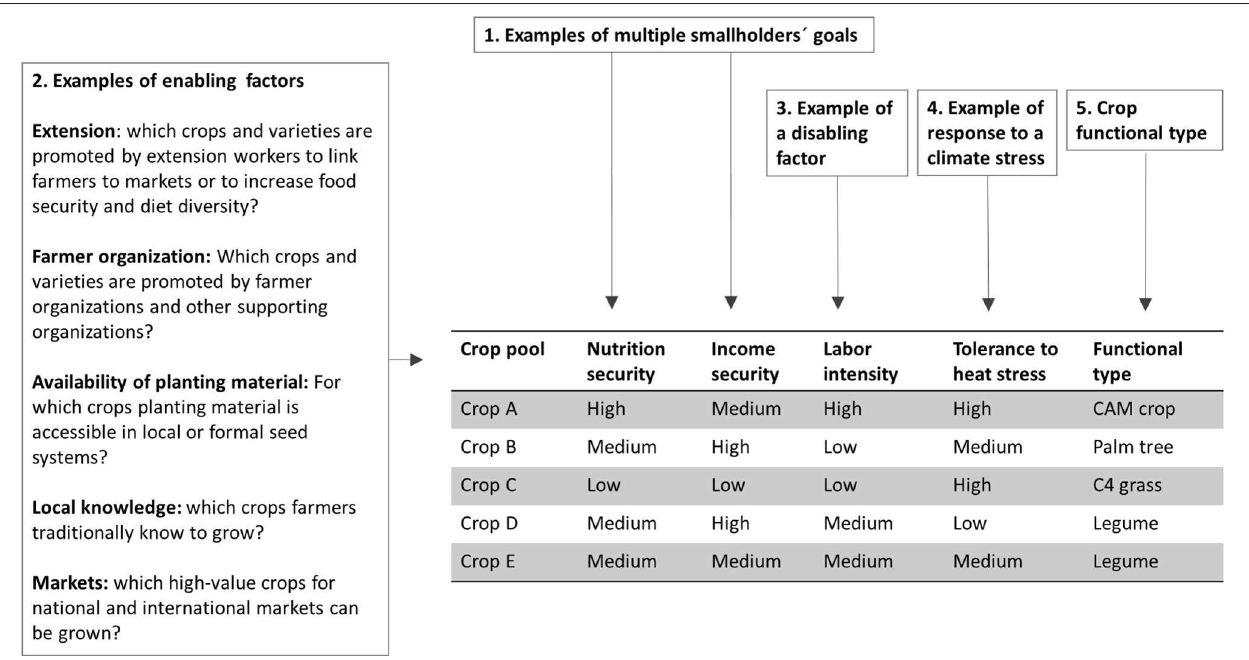
FIGURE 2 | Decision model to select crops and management practices for on-farm diversification. The existing enabling factors as defined in step 2 determine the availability of crop choices. Crops can be chosen using multiple criteria in function of the farmers’ goals defined in step 1; disabling factors defined in step 3; climate stresses defined in step 4; and a gap analysis of functional diversity in step